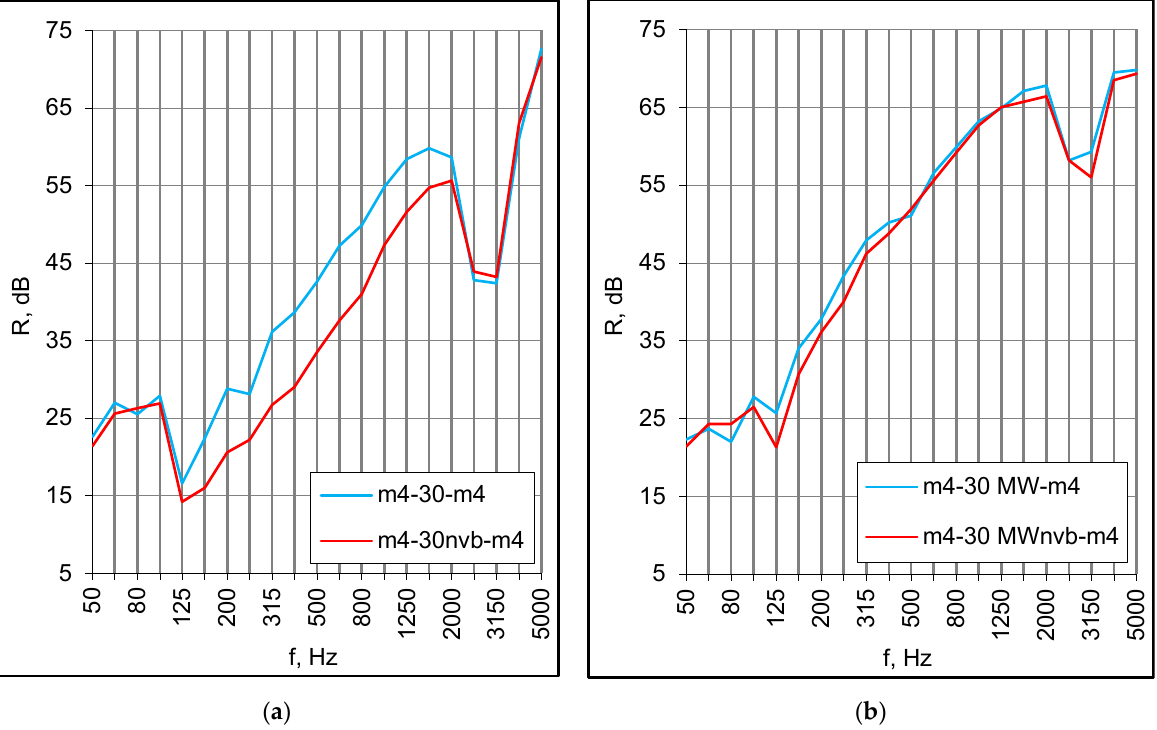
Figure 9. ( a ) The effect of an absence of a vibration break (nvb), double set-ups with an empty cavity; ( b ) The effect of an absence of a vibration break (nvb), double set-ups with mineral wool (MW).